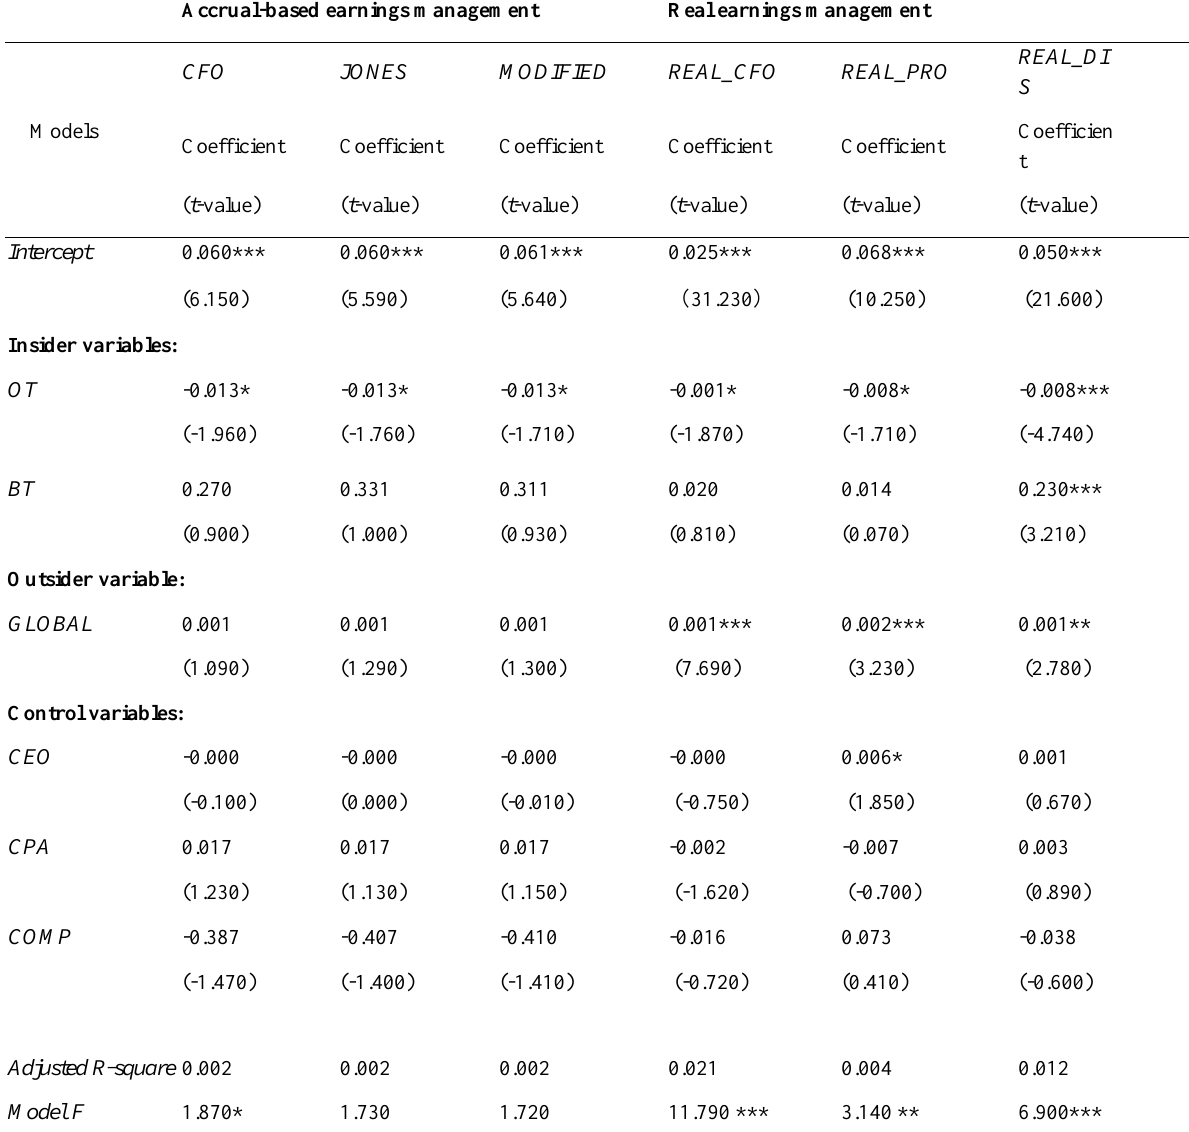
Table 2 Results of Multiple Regression （Ｎ＝